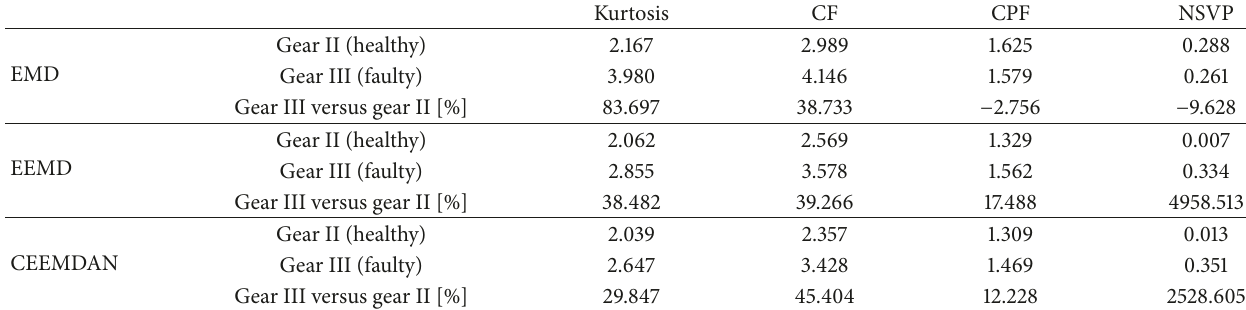
Table 3: CIs for the simulated signal with localized fault in gear